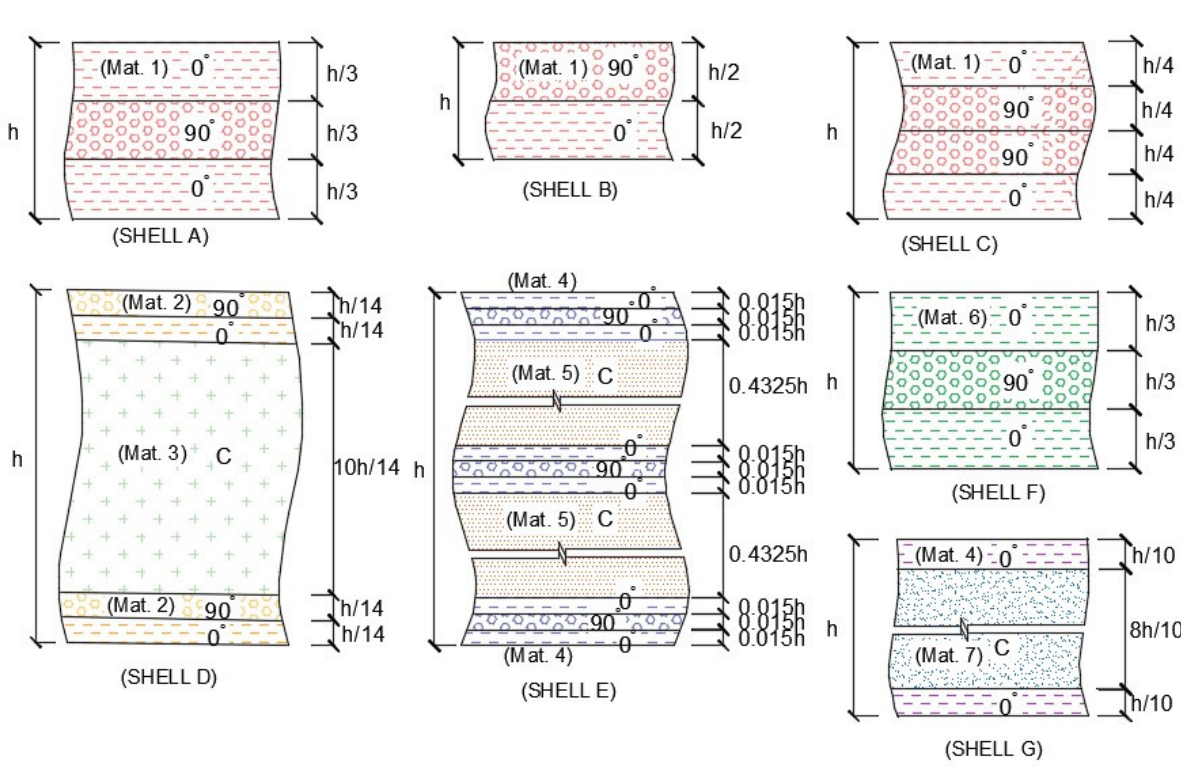
Figure 6: Configurations of composite and sandwich shells A, B, C, D, E, F, and